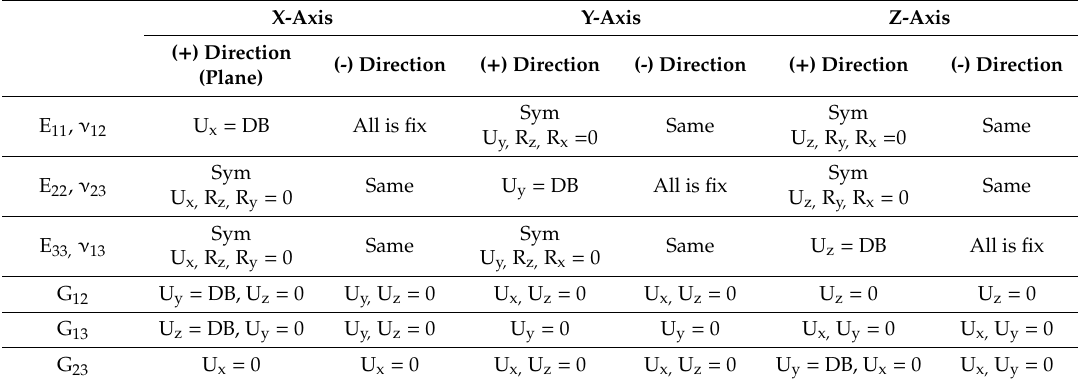
Table 3. Finite element analysis (FEA) boundary conditions for respective elastic constants.